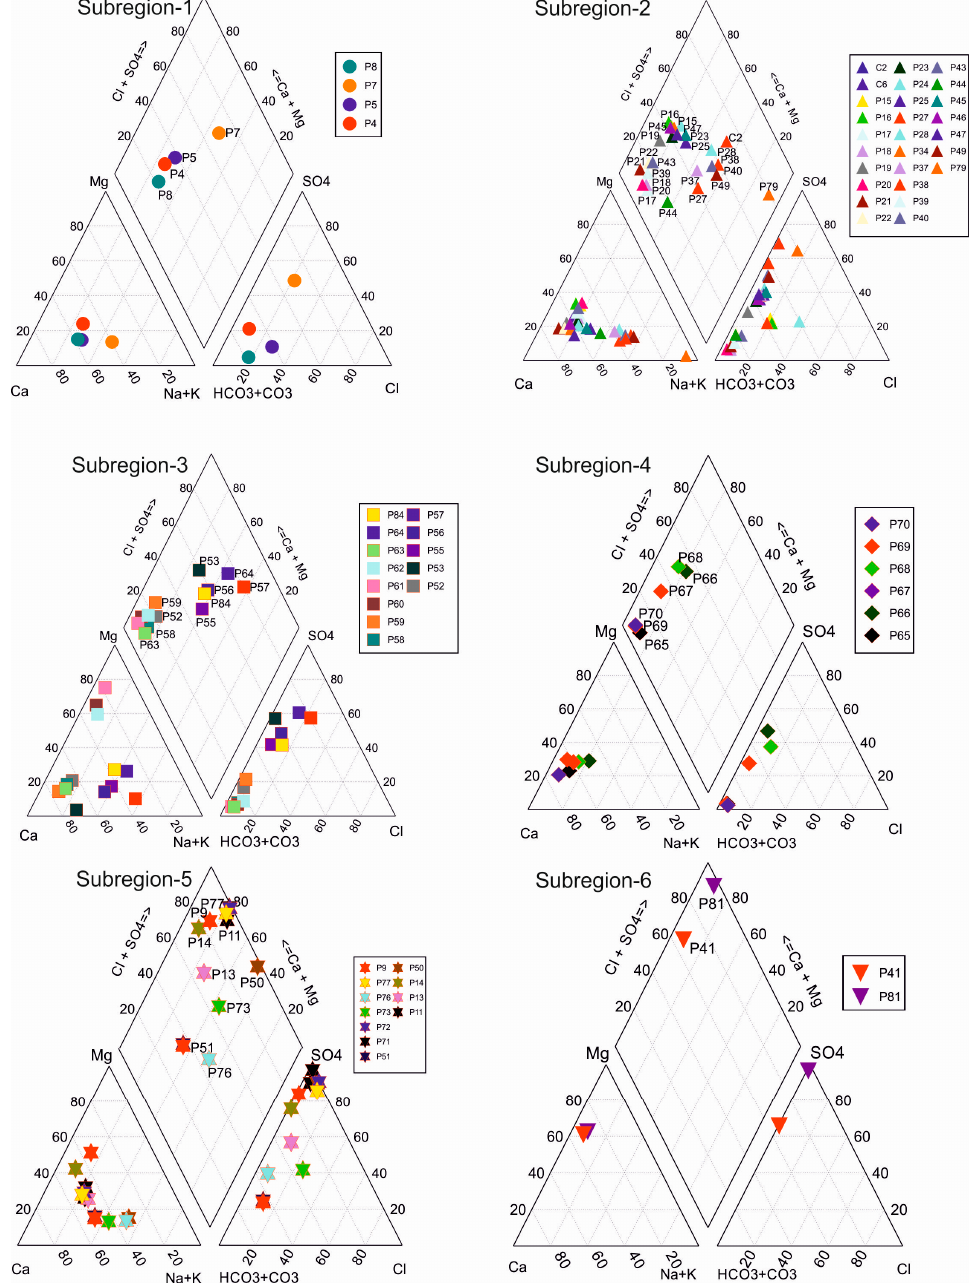
Figure 6. Classification of hydrochemical facies using the Piper diagram.